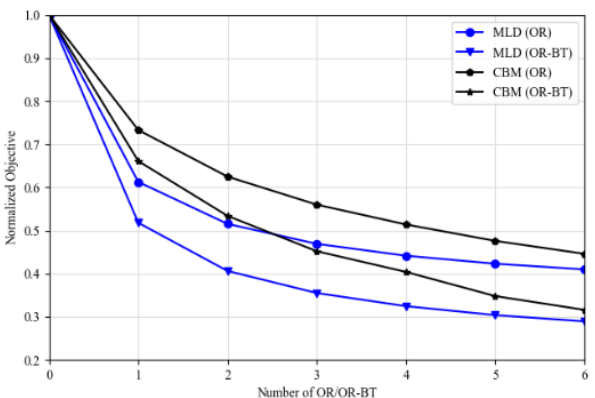
Figure 12. Result of each objective according to the number of OR/OR-BT